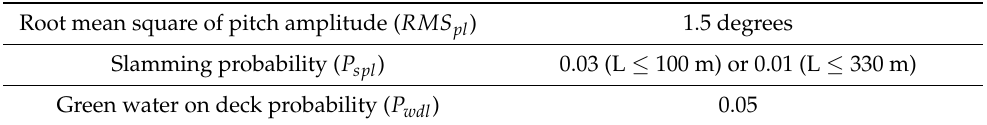
Table 1. General operability limiting criteria for ships. Root mean square of pitch amplitude ( RMS pl